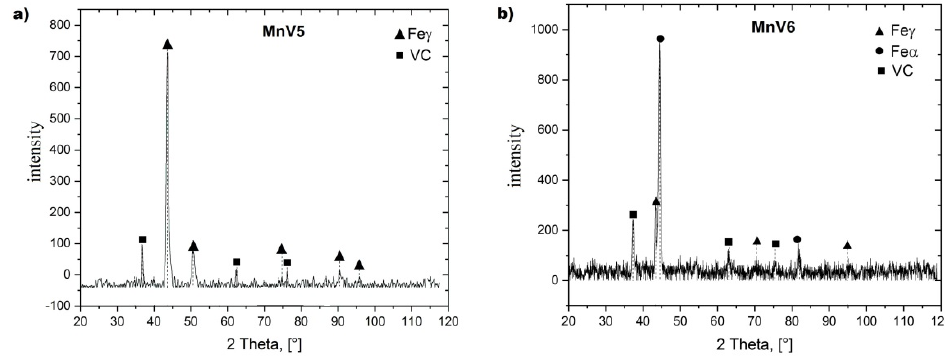
Figure 6. X-ray diffraction patterns of alloys containing ( a ) 5.5% V, and ( b ) 6.3% V.